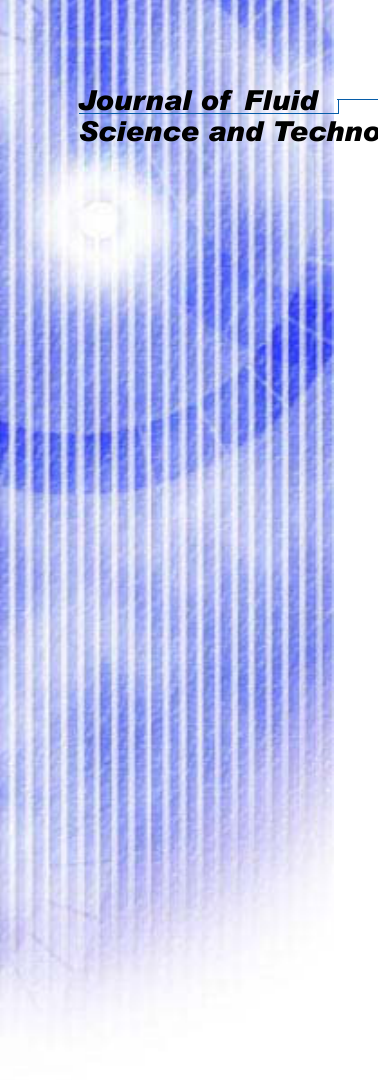
Fig. 13 Spectrum distributions of the aerodynamic noise generated from the arc blade